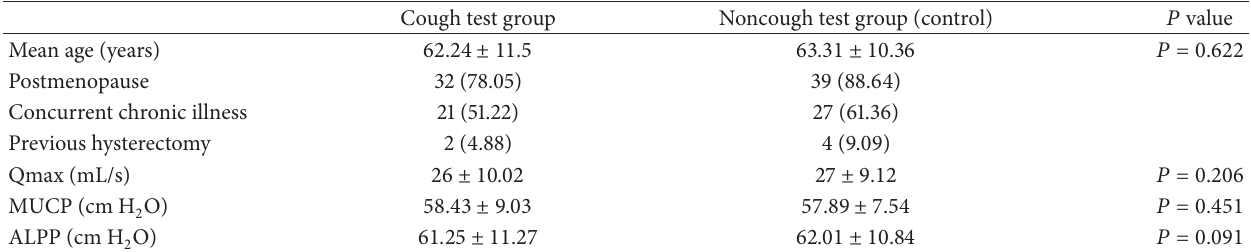
Table 1: Patient demographics and preoperative urodynamic parameters.